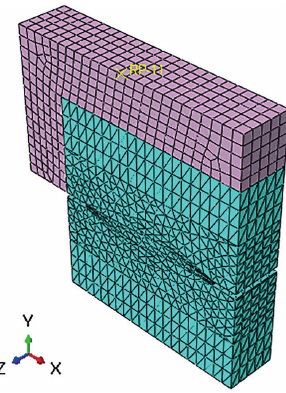
Fig. 12. Dual-border cut specimen under shear